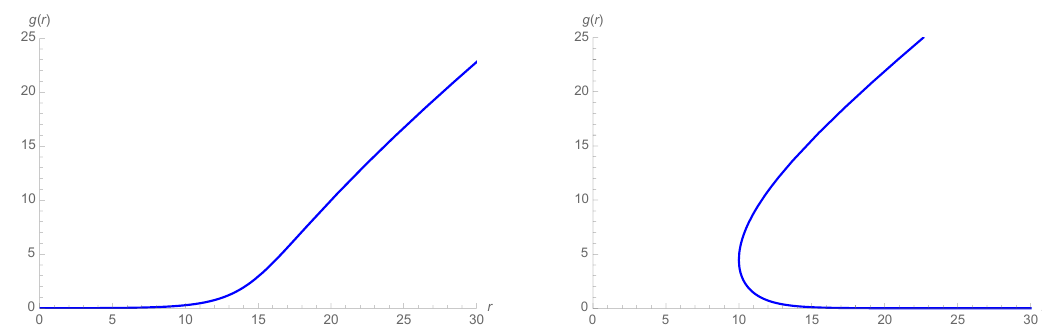
Figure 16 . (left) a numerical solution to the di(cid:11)erential equation (4.36), (right) a numerical solution to the di(cid:11)erential equation